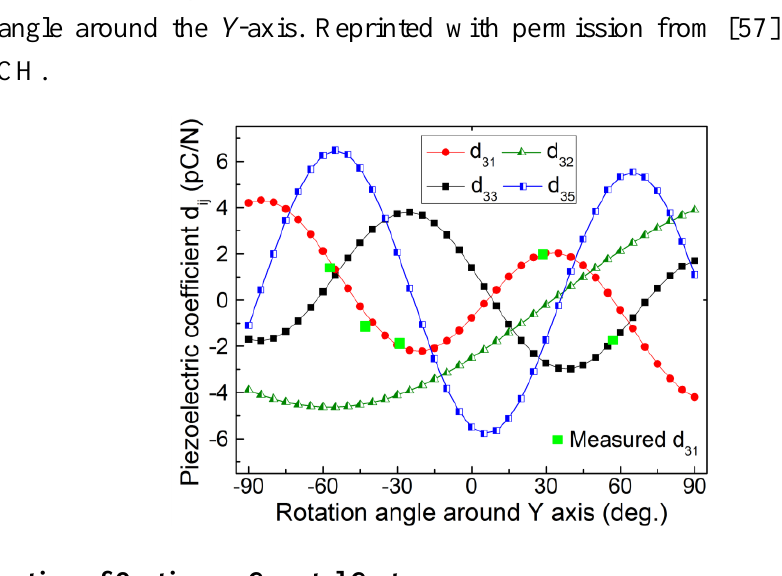
, d , d , and d as a function of the 31 32 33 35